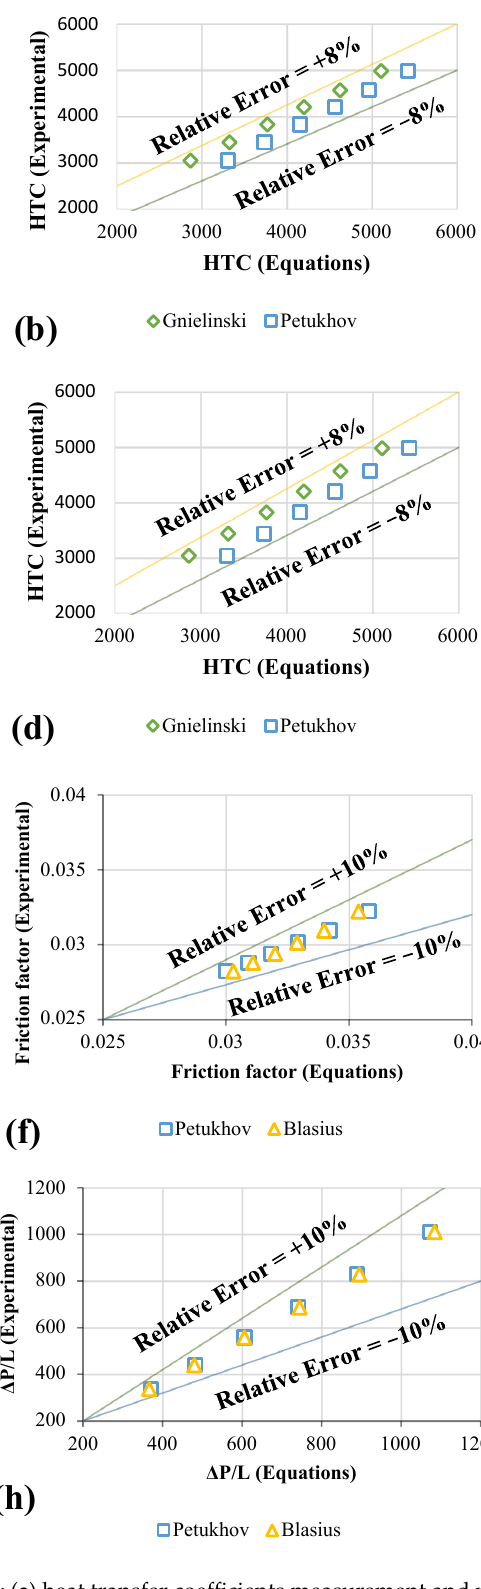
Figure 6. The verification assessment; ( a ) heat transfer coefficients measurement and prediction for 11,205 W/m 2 , ( b ) the magnitude of the relative error metric, ( c ) The value of the average Nusselt number at 11,205 W/m 2 , ( d ) the magnitude of the relative error metric, ( e ) Frictional head loss, ( f ) the magnitude of the relative error metric, ( g ) Pressure loss, ( h ) the magnitude of the relative error metric. Assessment of the experimental friction factor was calculated based on the measure- ment of the pressure loss in the entire applied heating pipe. The validation and verifica- tion procedures have been carried out using the Blasius and Petukhov equations for smooth pipes [44,45]. The validation of the experimental data for pressure loss and friction factor is shown in Figure 6e–g, while that of the data from the equations and the current study is shown in Figure 6f–h. 3.4. Convective Heat Transfer of Functionalized Nanofluids The prepared samples in this study were made without adding surfactant due to their long-term stability [46]. The present study analyzed functionalized and commercial metallic oxide nanofluids to enhance convective heat transfer inside a square heat ex- changer. Essentially, turbulent forced convective flow is typically conducted under heat transfer demands. The convective heat transfer coefficients of the functionalized and metal oxides-based nanofluids are shown in Figure 7a versus multiple nanofluids and Re-numbers. Increased nanofluids convective heat transfer coefficient as the velocity of the working fluid in- creased. This improvement resulted from solid nanoparticles’ Brownian forces, thermal diffusion, and thermophoresis [47]. In the meantime, the increase in heat transfer might also result from the thin thermal boundary layer, which caused the higher velocities that caused thermal conductivity and decreased thermal resistance between the flowing nanofluid and the temperature of the internal wall surface of the heated pipe. Compared to DW, the maximum increase in heat transfer coefficients was as follows: PEG@GNPs = 44.4%, PEG@TGr = 41.2%, Al 2 O 3 = 22.5%, and SiO 2 = 24% at 0.1 wt.%. As per experimental data, the increase in heat transfer, as per test data, may be due either to the delay of the thermal boundary layers or due to increased thermal conductivity of the nanofluids.